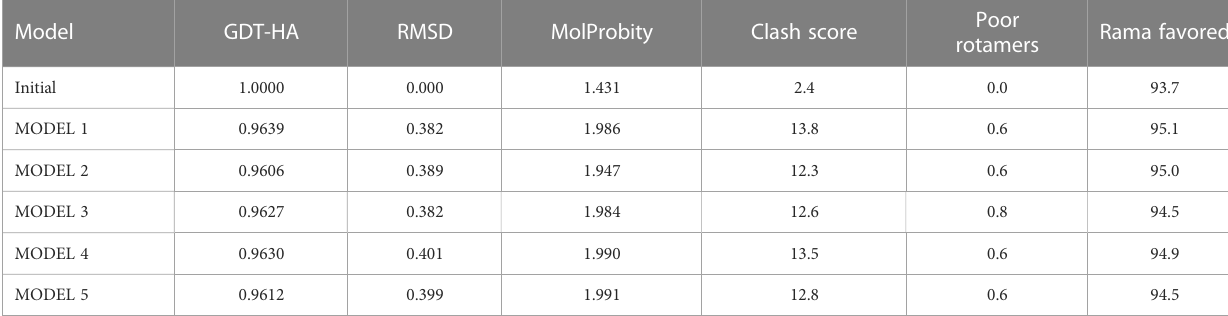
TABLE 10 structure information of galaxy re fi ne web server.